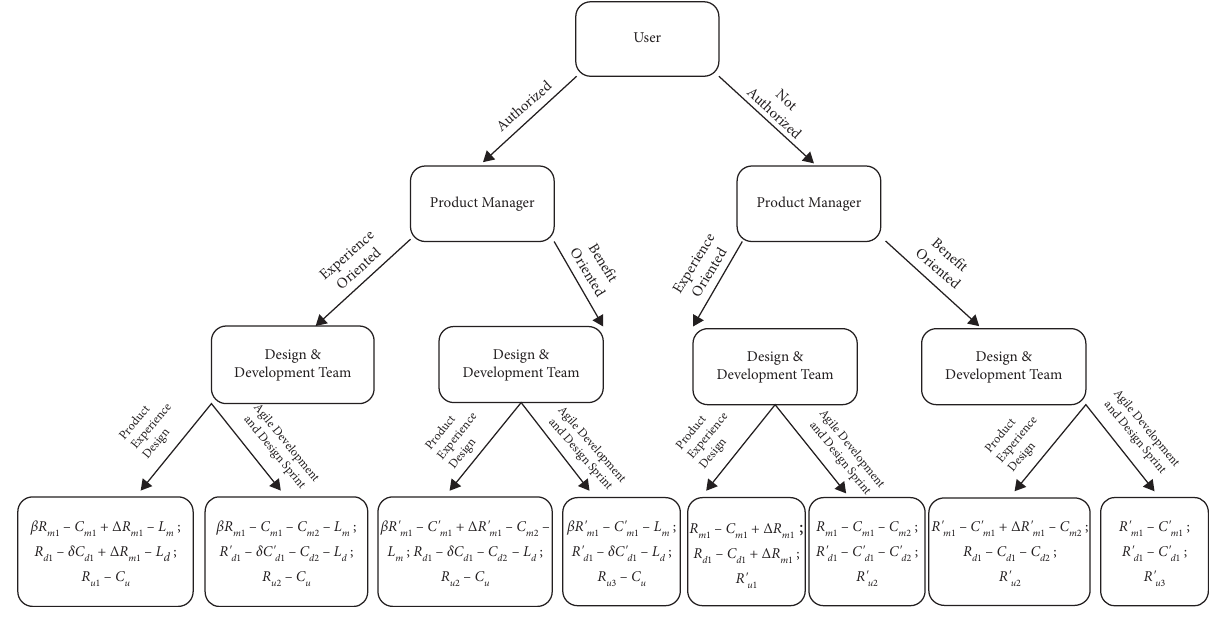
Figure 3: The tripartite game tree. Table 2: Payment matrix under user-selected authorization information sharing policy ( z ).